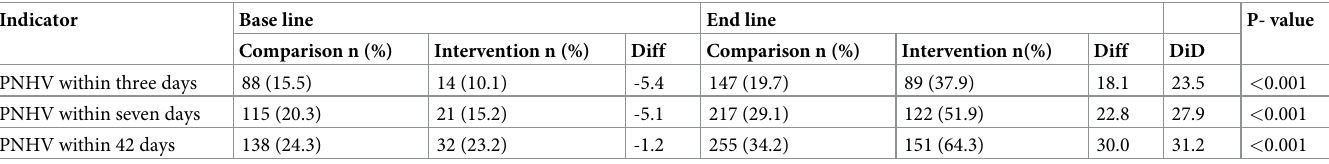
Table 3. Effect of the intervention on maternal and newborn PNHV